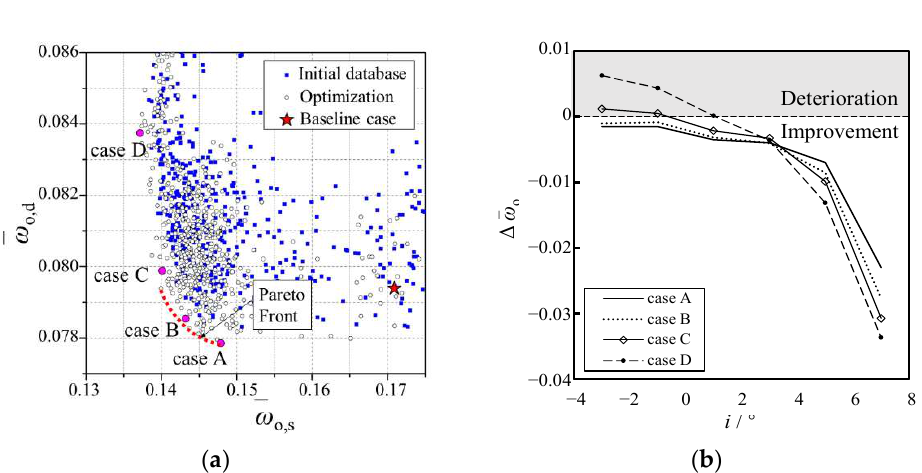
Figure 8. The total pressure loss of profiling cases. ( a ) All cases in the optimization design process; ( b ) the variation of total pressure loss of case A to case D at multiple incidences.